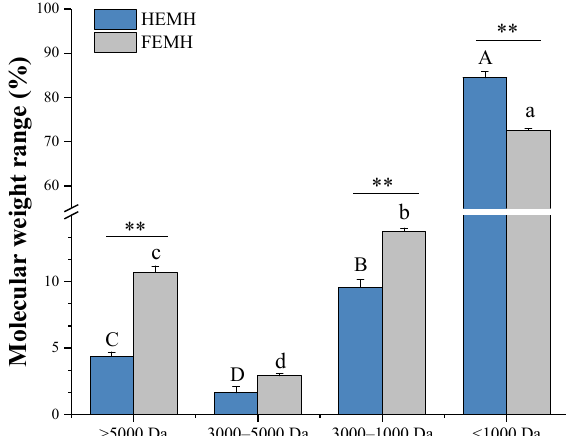
Figure 3. Molecular weight (MW) distribution of hydrolysates of hatched eggshell membrane (HEMH) and fresh eggshell membrane (FEMH). Values are expressed as mean ± SD ( n = 3). Different letters in FEMH (A–D) or HEMH (a–d) with MW > 5000 Da, 3000–5000 Da, 1000–3000 Da, and <1000 Da mean significant differences for different MW comparisons ( p < 0.05), and the significance levels of ** p < 0.01 are for FEMH versus HEMH at the same MW.